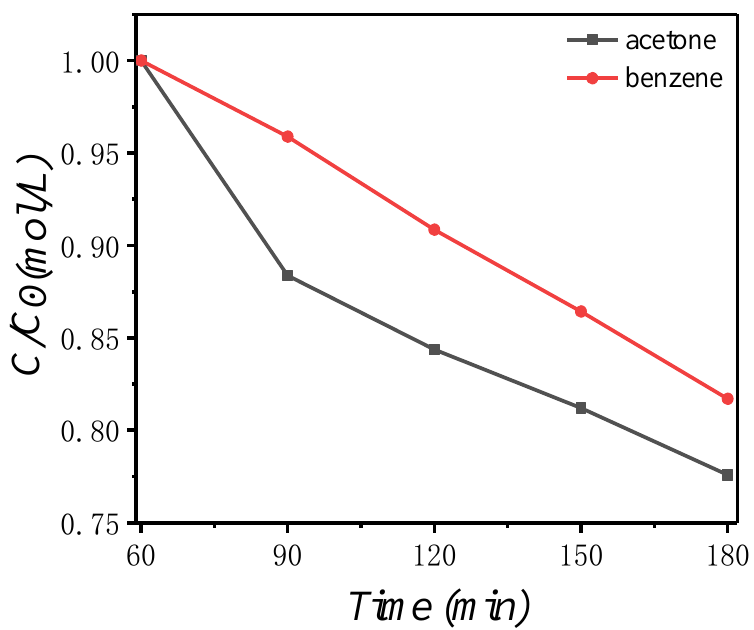
Figure 12. Photodegradation of certain concentrations of gaseous acetone and gaseous benzene over 10% ZnO@diatomite under visible light irradiation.